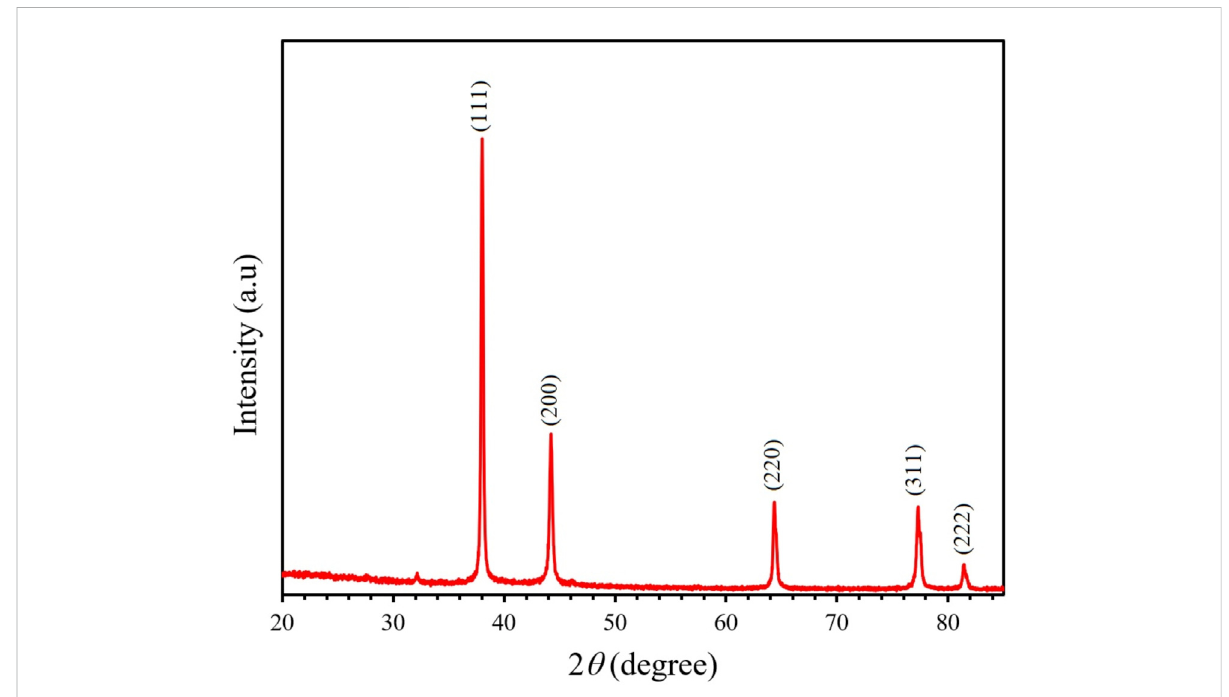
XRD spectra of the synthesized AgNP. Peaks appeared at 111, 200, 220, 311, and 222 plane lattice.